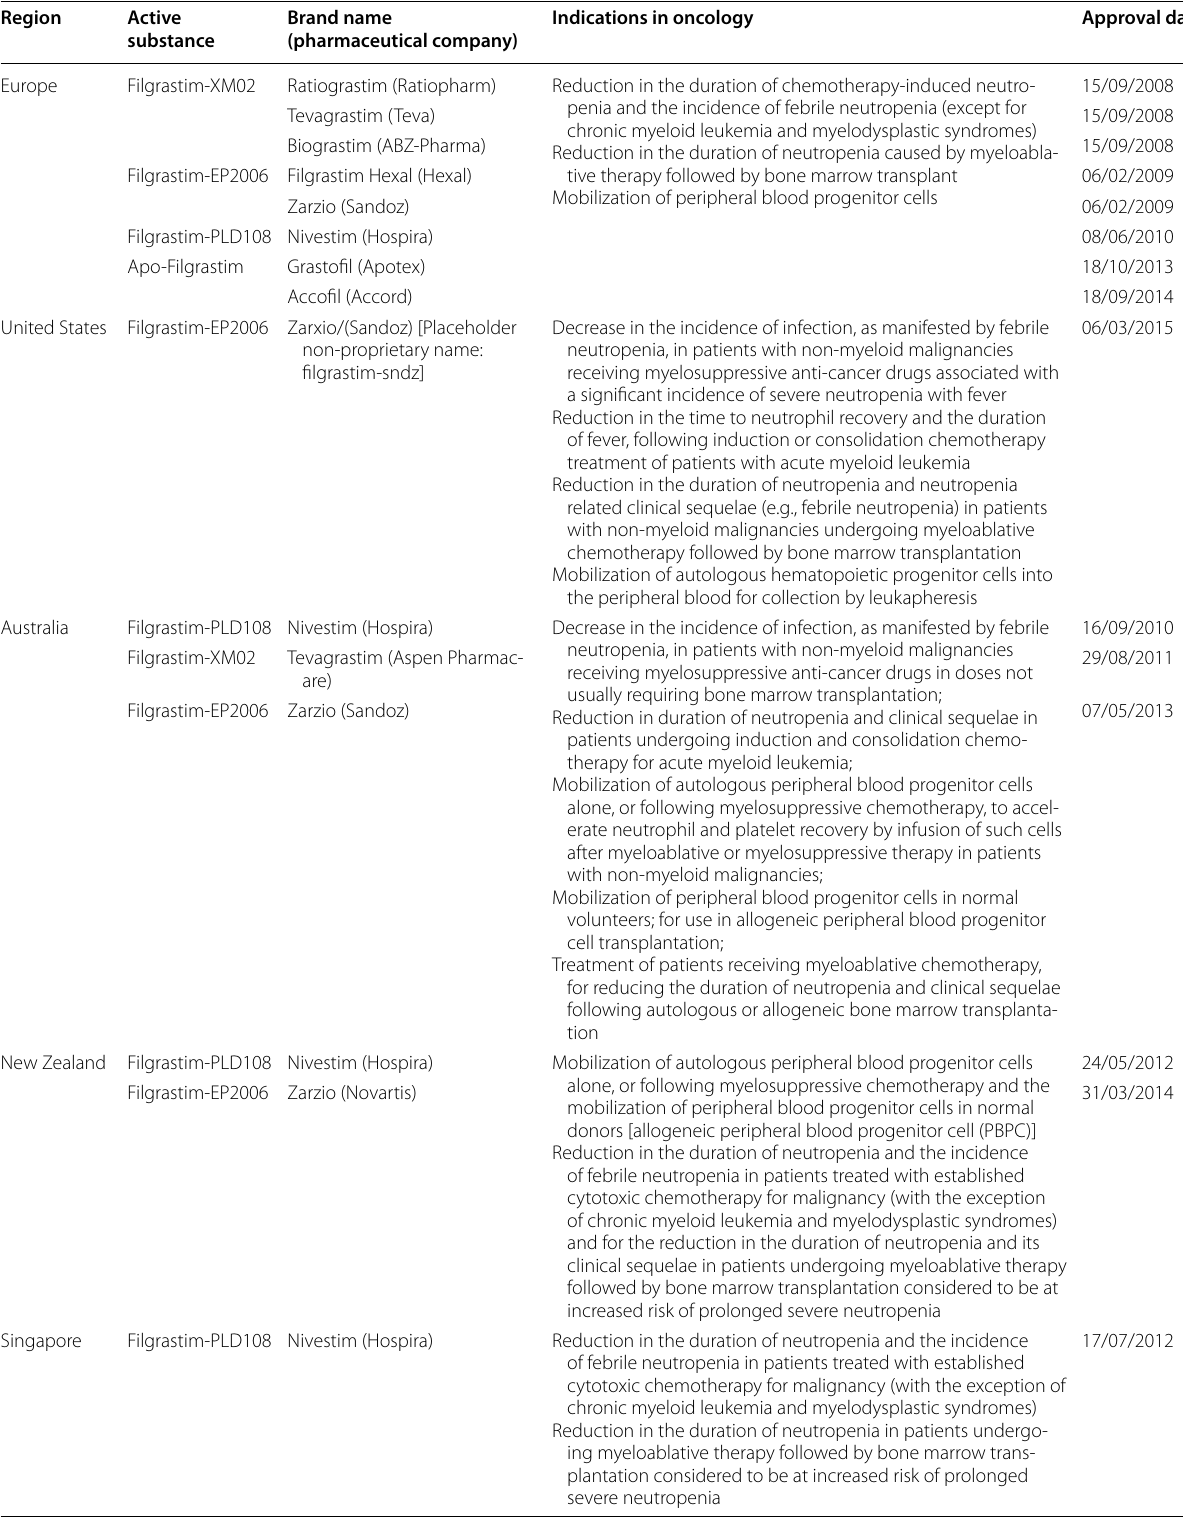
Table 5 List of currently approved granulocyte colony-stimulating factor biosimilars